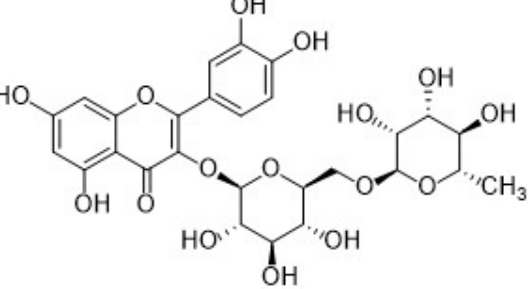
Figure 22. Chemical structure of rutin (RT).